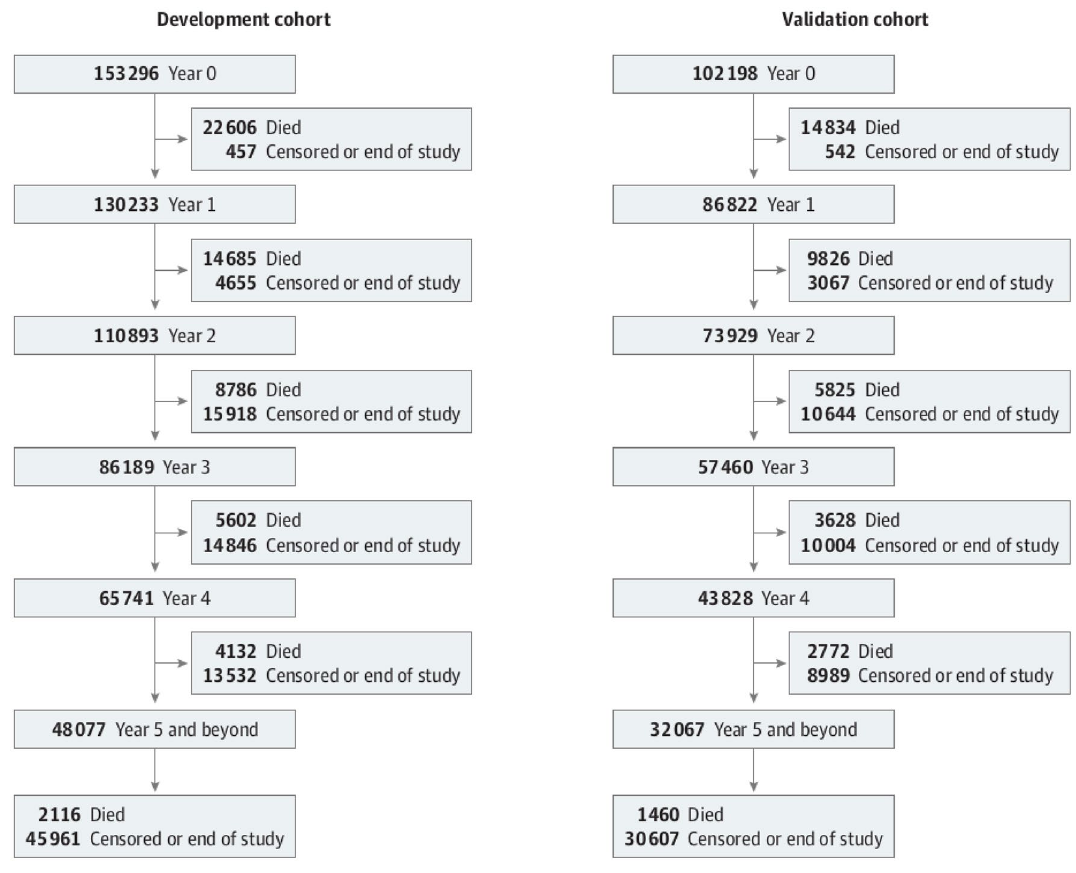
Figure 6. The yearly cohorts defined by Seow et al. 5 .